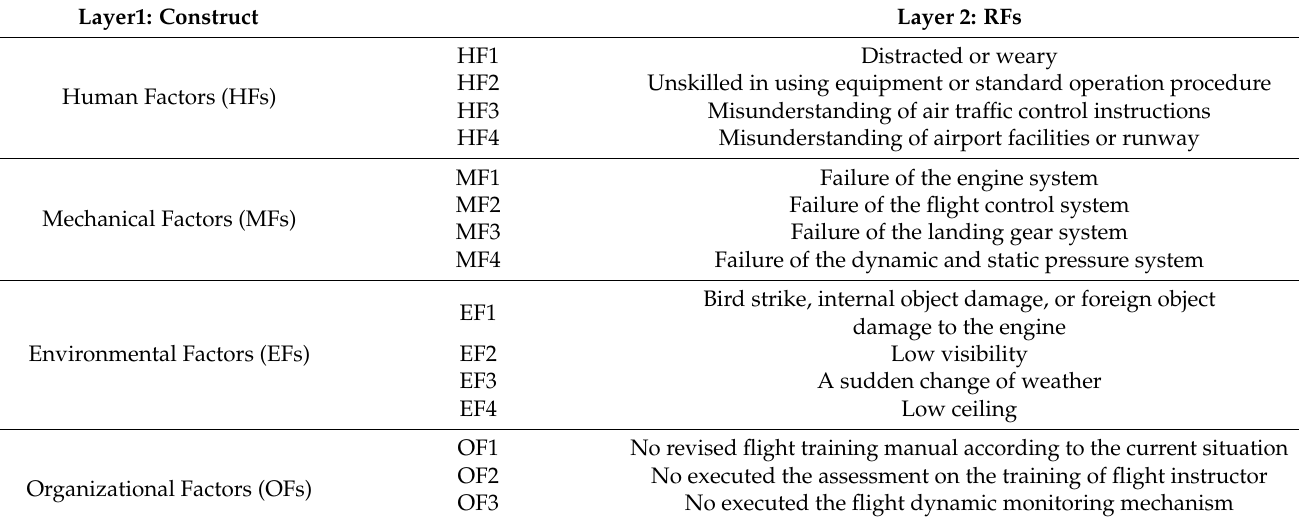
Table 1. The RFs of flight